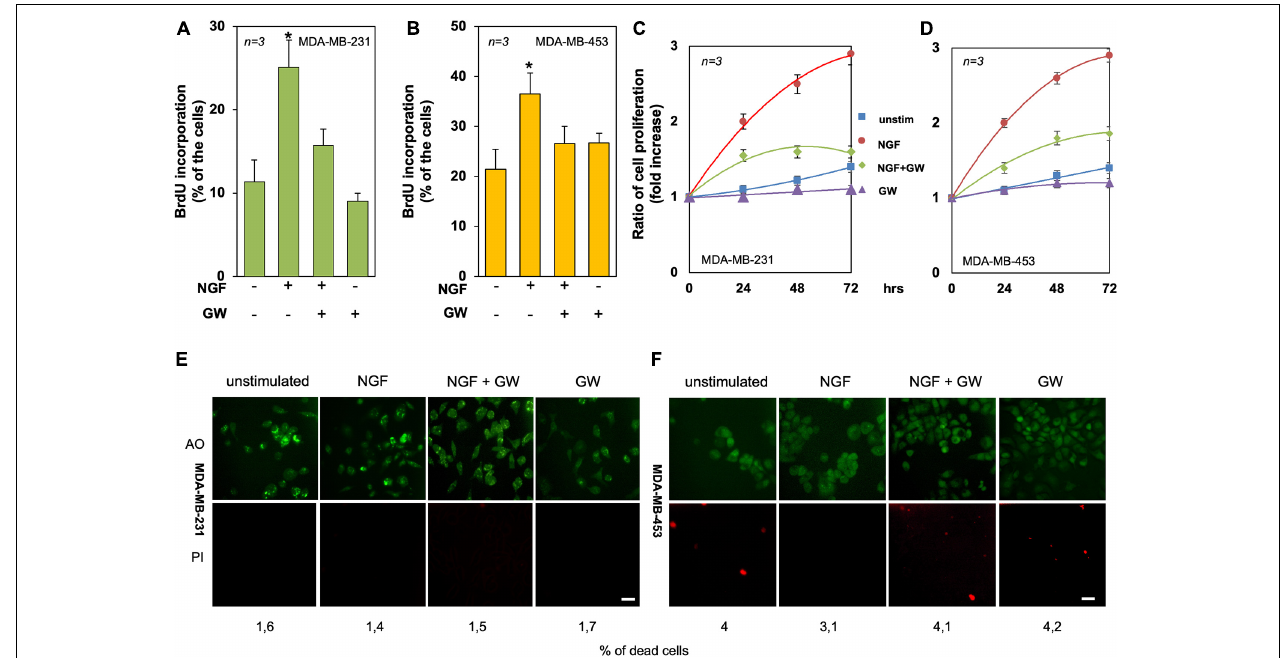
FIGURE 4 | Tyrosine kinase A (TrkA) mediates the neurotrophin β -nerve growth factor (NGF) mitogenic effect in triple-negative breast cancer (TNBC) cells. (A,B) Quiescent MDA-MB-231 (A) and MDA-MB-453 (B) cells were left untreated or treated for 18 h with the indicated compounds. Cells were pulsed in vivo with 100 µ M BrdU and its incorporation into DNA was analyzed by immunofluorescence (IF) and expressed as the percentage of total cells. (C,D) Quiescent MDA-MB-231 (C) and MDA-MB-453 (D) cells were left untreated or treated for 24, 48, and 72 h with the indicated compounds. Cell proliferation was assayed using the WST-1 reagent. Graphs represent the ratios of proliferation, which was expressed as the fold increase over the basal absorbance. NGF stimulation induced a significant ( p < 0.05) increase in cell proliferation as compared with the untreated cells. (E,F) MDA-MB-231 (E) and MDA-MB-453 (F) cells were untreated or treated for 72 h with the indicated compounds and stained with the Cyto3D reagent. Shown are IF images of the total ( green ) and dead ( orange ) cells, representative of three different experiments. Scale bar , 10 µ m. The percentages of dead cells for each point are indicated in the figure. In (A–F) , NGF was used at 100 ng/ml and GW441756 (GW) was used at 1 µ M. Means and SEMs are shown. n represents the number of experiments. * p < 0.05 for the indicated experimental points vs . the corresponding untreated